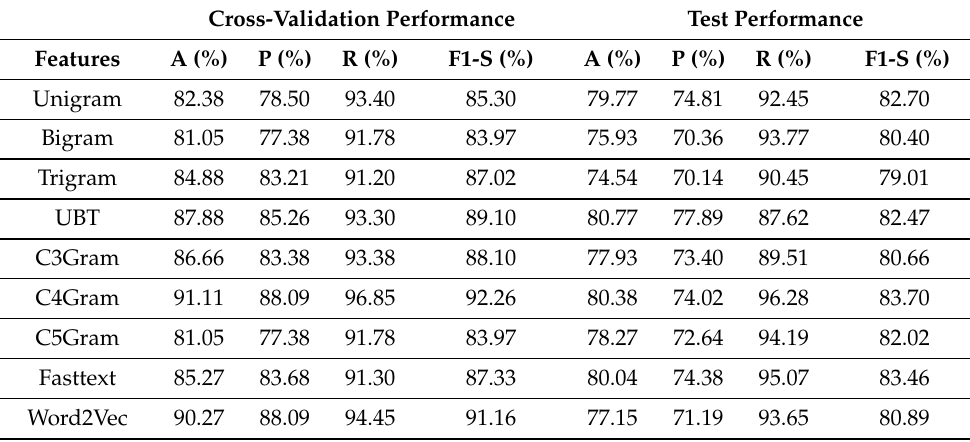
Table 6. Performance of Decision Tree (DT) machine learning classifier.